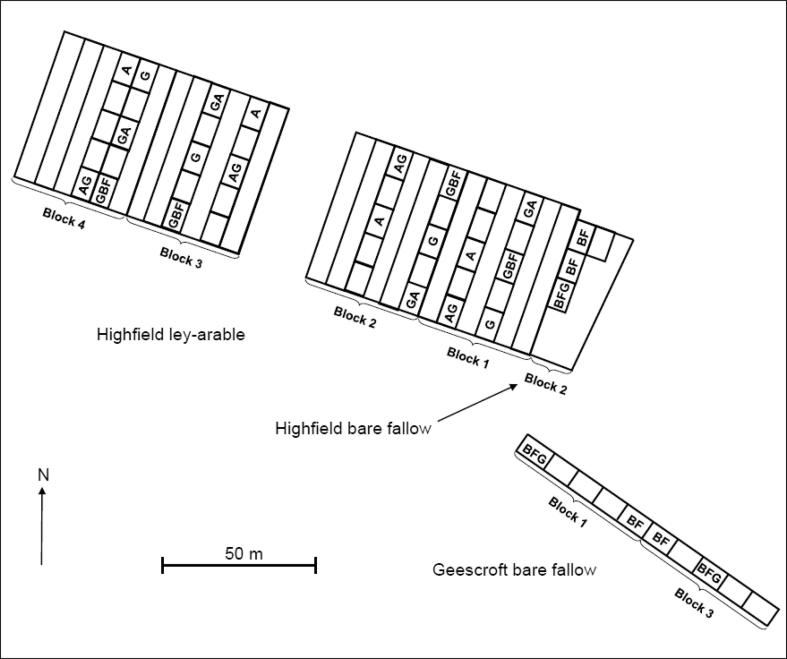
Distribution of plots in Highfield showing the arable (A), arable converted to grass (AG), grass converted to bare fallow (GBF), grass converted to arable (GA) and grass (G) treatments in blocks 1–4 of the ley-arable experiment, and the bare fallow (BF) and bare fallow converted to grass (BFG) treatments in blocks 1–3 of the adjacent bare fallow experiments.